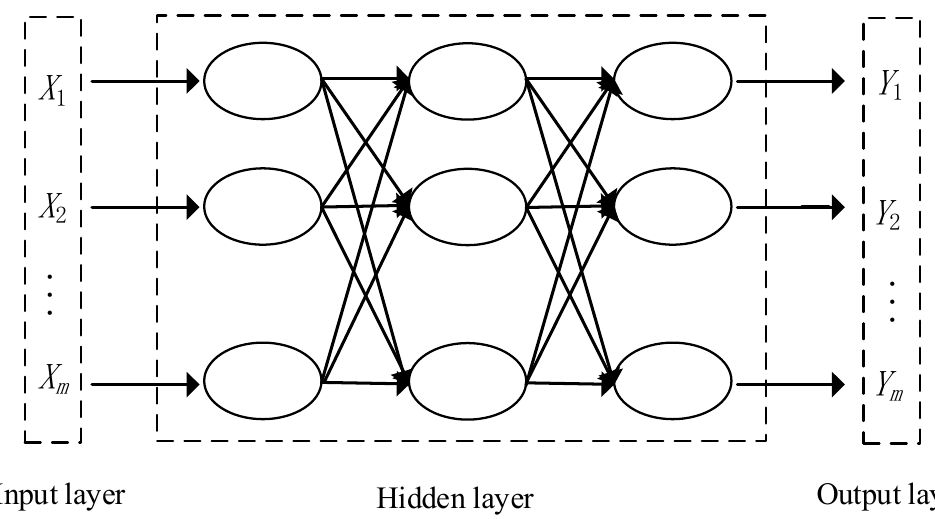
Figure 1. Backpropagation neural network (BPNN) structure.